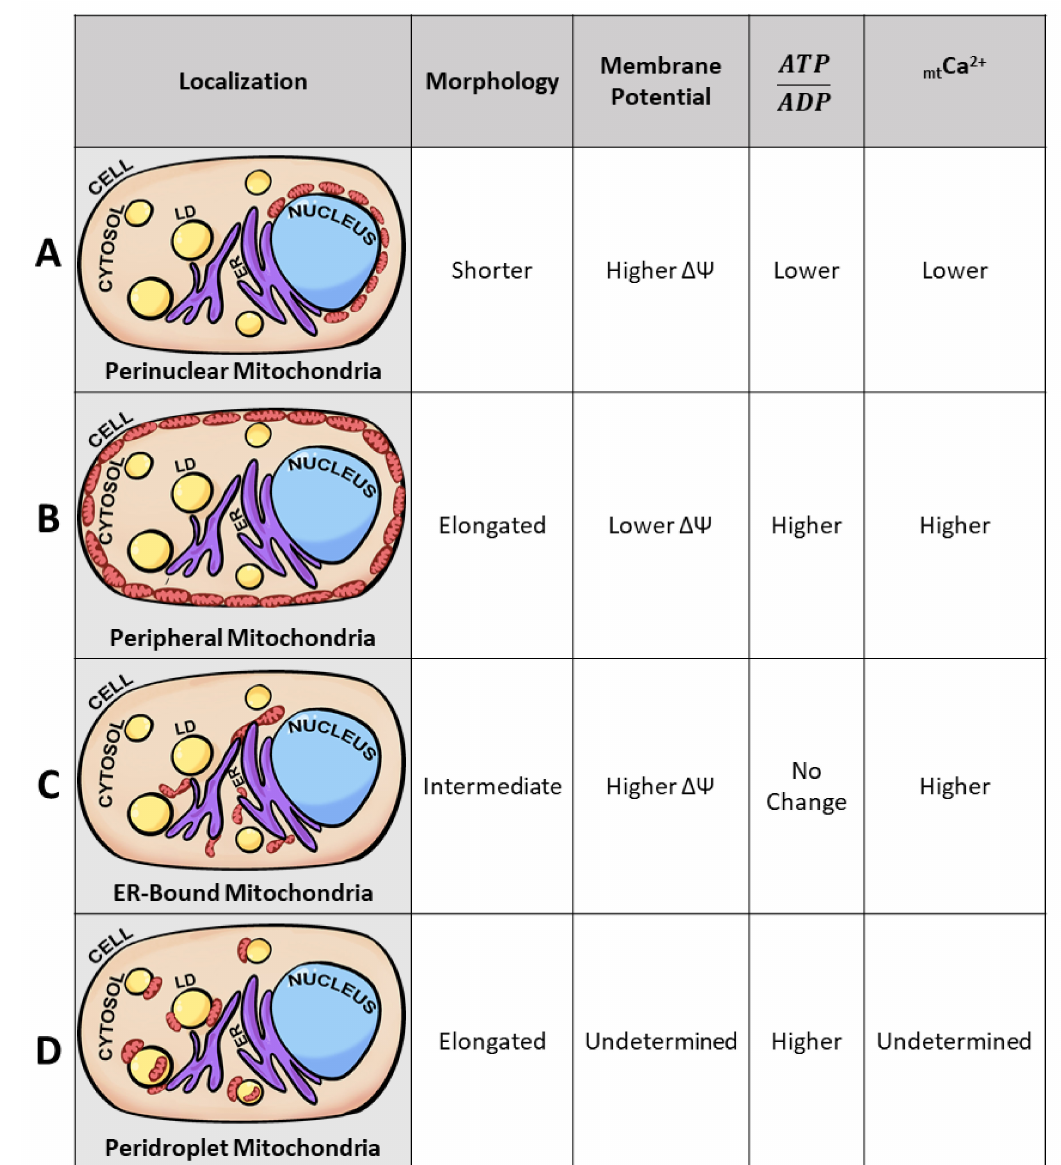
Figure 3. Mitochondrial subpopulations reveal unique mitochondrial traits. Diagram of a typical cell containing nuclei (blue), lipid droplets (LD) (yellow), endoplasmic reticulum (ER) (purple), cytoplasm (peach), and mitochondria (red ovals). Proposed model of distinct mitochondrial subpopulations observed across several cell types. Mitochondria of specific subcellular localizations have unique traits demonstrating that not all mitochondria are homogeneous under physiological states. Based on previous studies [4,23,75,77,80,82–87] we observed the presence of 4 mitochondrial subpopulations: perinuclear, peripheral, ER-bound, and peridroplet mitochondria. The 4 mitochondrial subpopulations have been observed to exhibit differences in morphology, membrane potential, ATP/ADP ratios, and mitochondrial calcium ( mt Ca 2+ ) levels. Mitochondrial length is dictated from longest length (elongated), intermediate length, and shortest length (shorter). Higher substrate concentrations are dictated as higher, and reduced substrate concentrations are dictated as lower in the table according to mitochondrial subpopulation. ( A ) Perinuclear mitochondria, localized to the nucleus, display higher membrane potential and reduced mitochondrial length. ( B ) Peripheral mitochondria, bordering the plasma membrane, display increases in mitochondrial length. ( C ) ER-bound mitochondria, tethered to the endoplasmic reticulum, yield higher mitochondrial calcium levels. ( D ) Peridroplet mitochondria, attached to lipid droplets, display elongated mitochondria compared to those in the